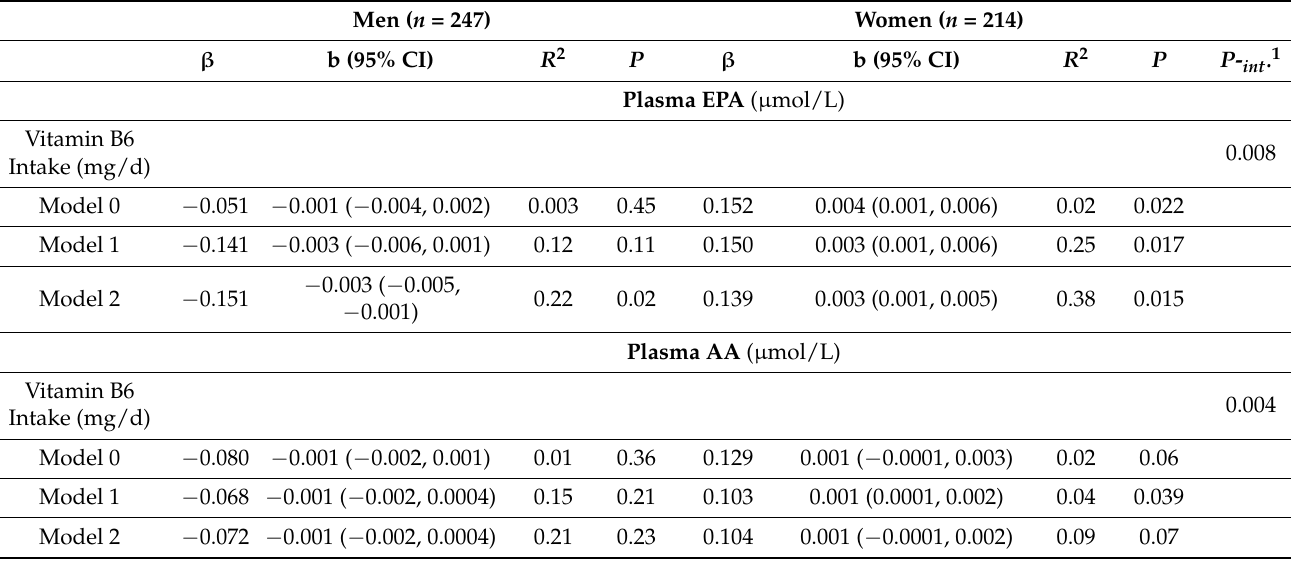
Table 3. Linear regression models: Associations of vitamin B6 intake with plasma EPA and